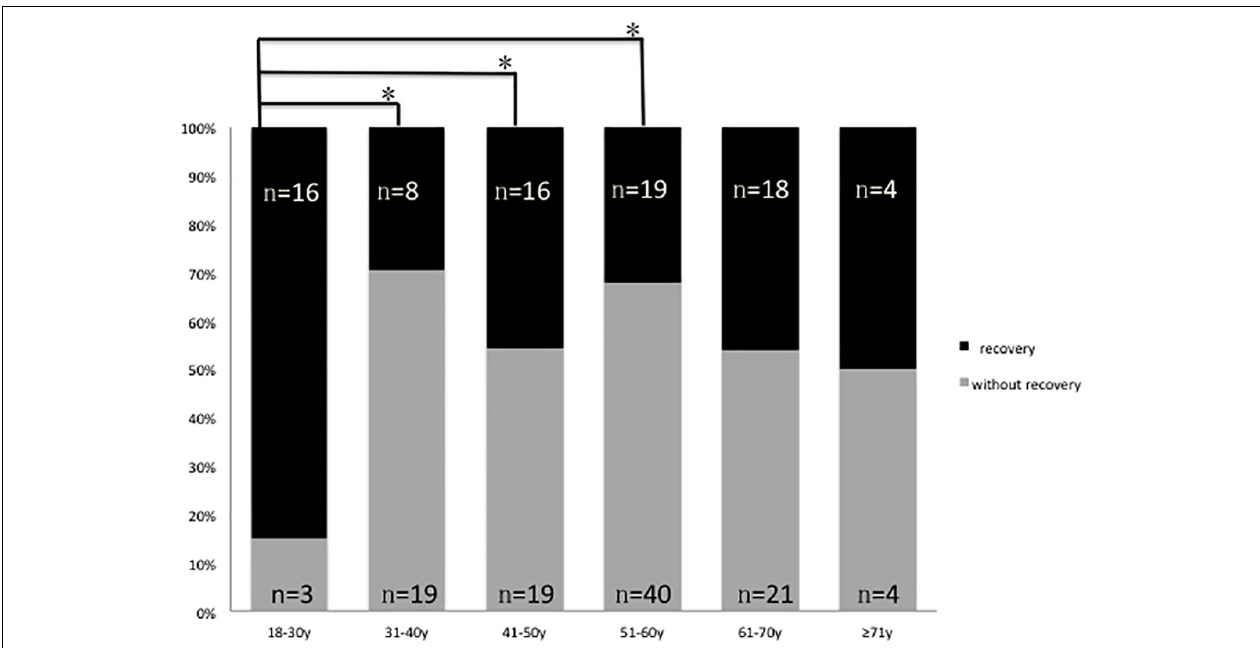
FIGURE 2 | Graphical presentation of the percentage of patients with (II, marked recovery) and without recovery (III + IV slight recovery + no recovery) in six groups, black: Number of patients with marked recovery (II) 1 month posttreatment; gray: Number of patients with slight recovery and no recovery (III + IV) 1 month posttreatment ∗ p 0.05.